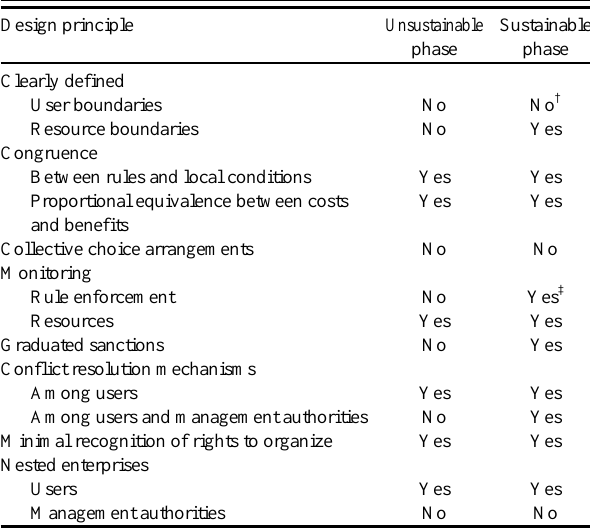
Table 1 . Design principles of robust, long-term, common pool resources during the unsustainable growth phase (1960–1972) and the sustainable phase (1994–2009) of the Peruvian anchovy